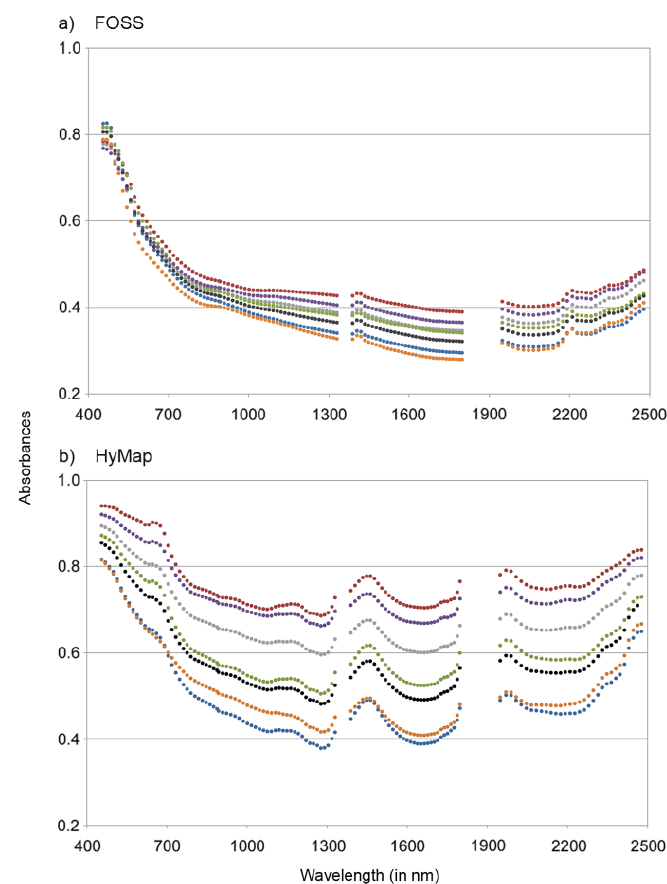
Figure 4. Examples of modeled ( a ) FOSS and ( b ) HyMap spectra that were fitted to measured values of OC and N (for clarification, spectra are illustrated for a subset of seven samples; absorbance defined as log 10 (reflectance −1 ).